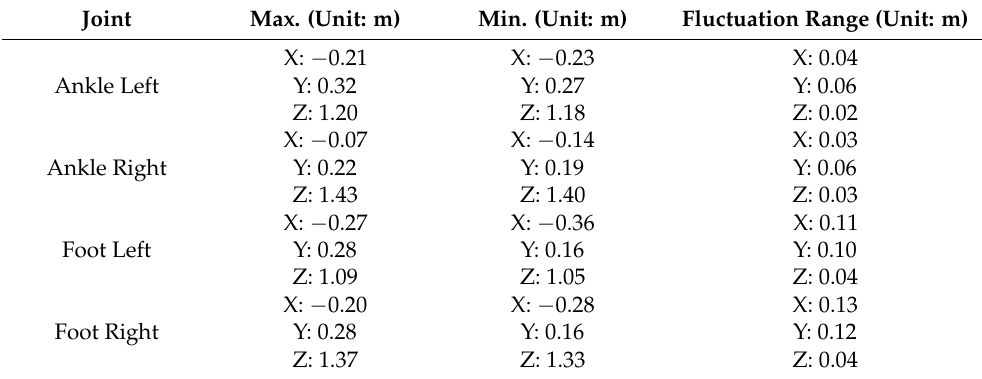
Table 1. Coordinate Movement Figures for Each